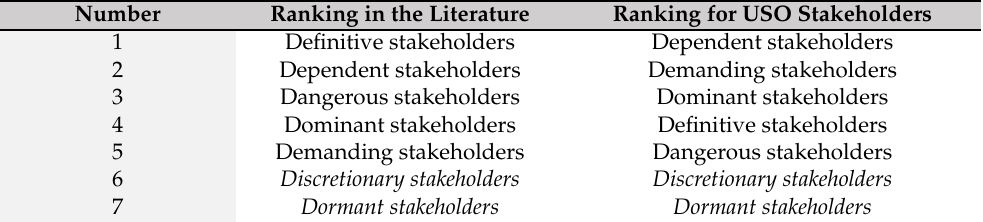
Table 8. Comparison between the ranking in the literature and the ranking from the respondents for question 11. Number Ranking in the Literature Ranking for USO Stakeholders Definitive